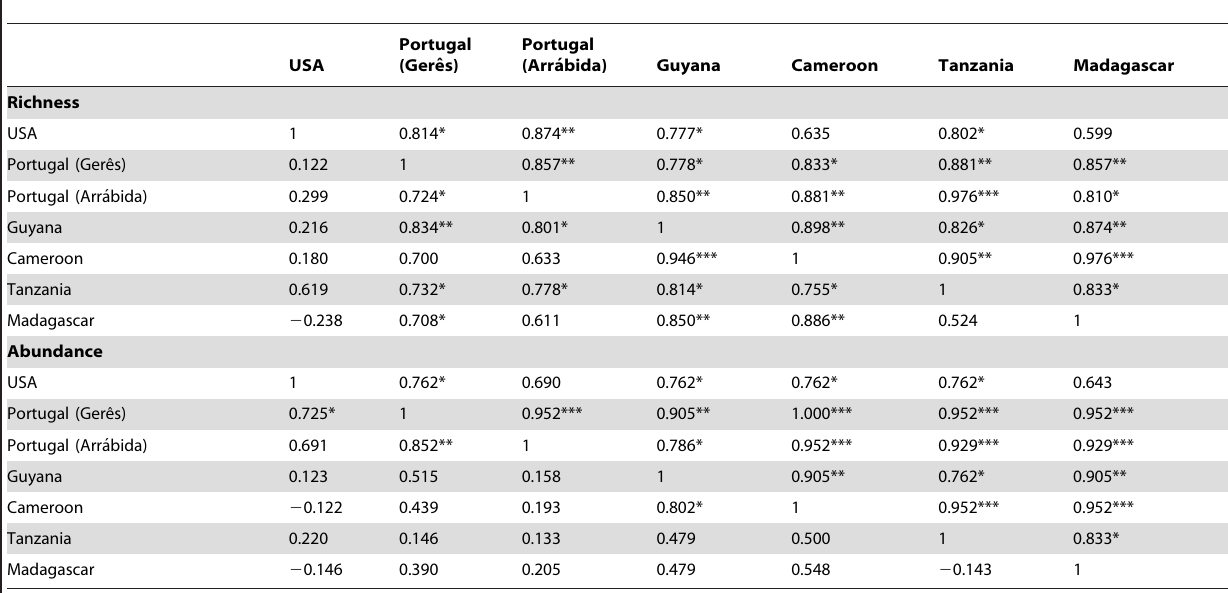
Table 2. Pairwise Spearman rank correlations of family and guild richness and abundance of studied sites.